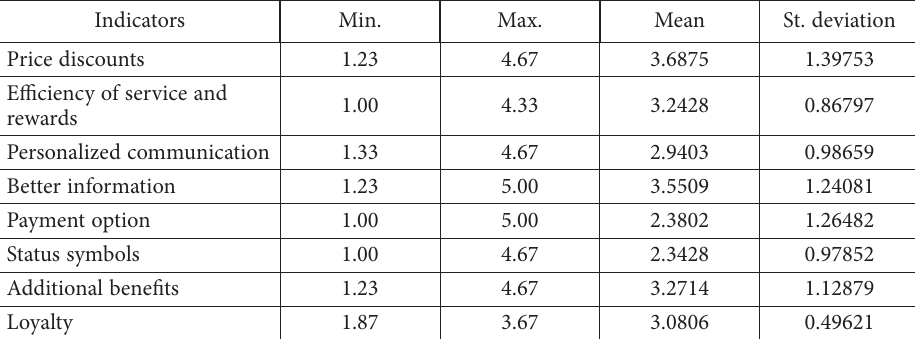
Table 3. Descriptive statistics for indicators and dependent